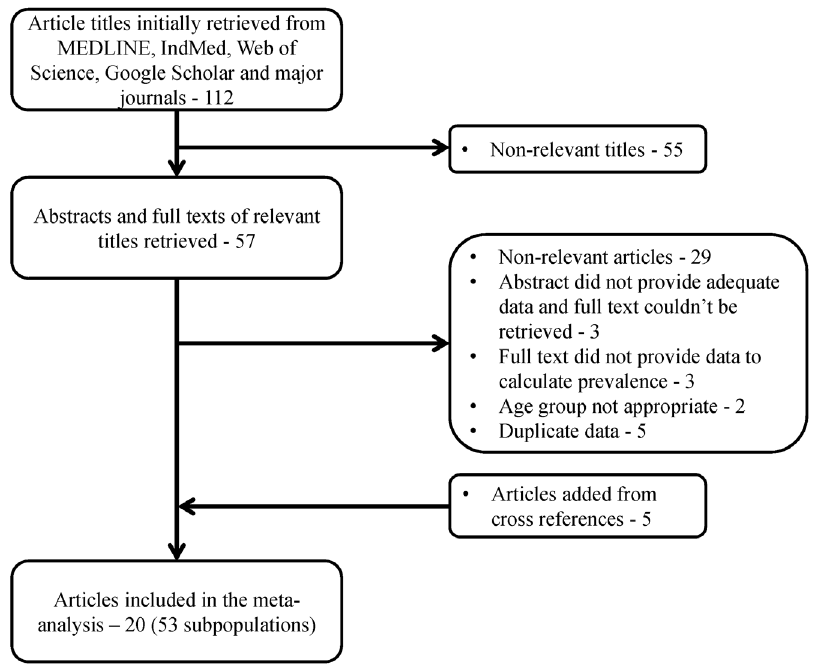
Figure 1. Flow of selection of studies.